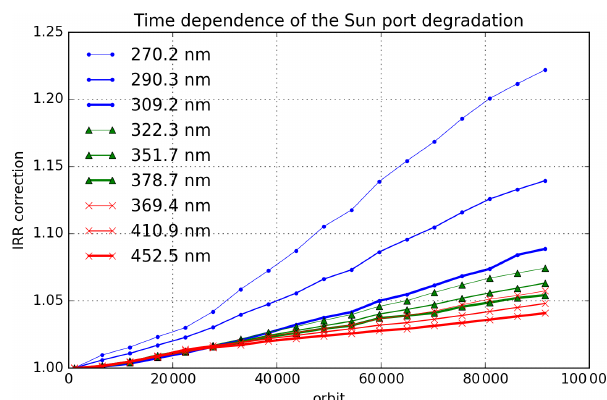
Figure 8. Time dependence of the degradation of the Sun port as observed over the entire mission, for three selected wavelengths per channel for detector row 300.